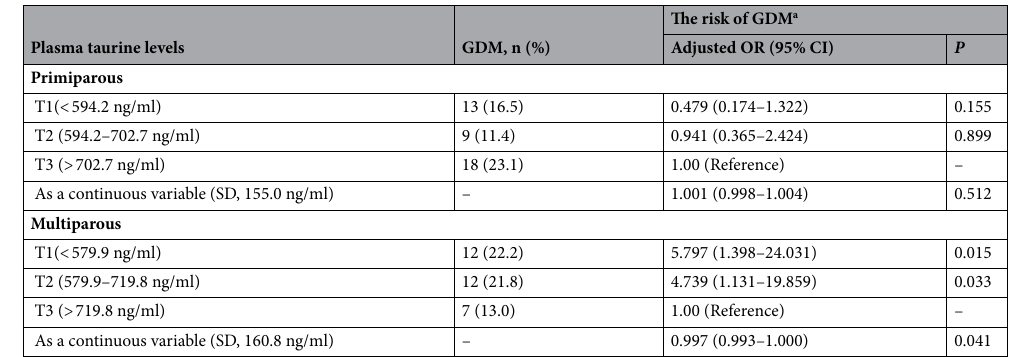
Table 3. Association of GDM risk with plasma taurine levels in primiparous and multiparous women. a Adjusted for age, physical activity, education level, BMI, weight gain (from enrolment to the 75-g OGTT), family history of diabetes, history of PCOS, use of multi-nutrients supplements, C-reactive protein, hemoglobin, ferritin, and serum homocysteine.